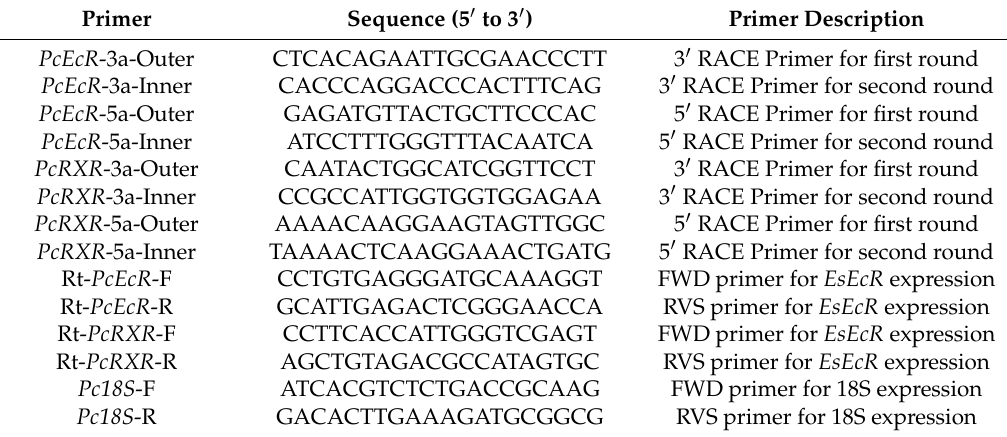
Table 1. Nucleotide sequences of primers for PcEcR and PcRXR cloning and expression